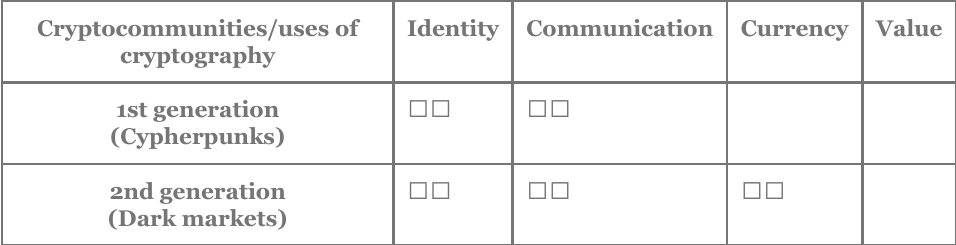
Table 2: Three generations of crypto